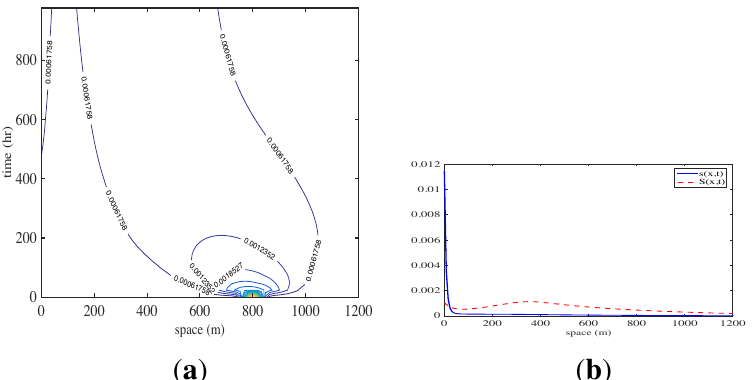
( a ) Evolution of contours of S ( x, t ) ; ( b ) at t = 1000 h, the distribution of s (solid) and S